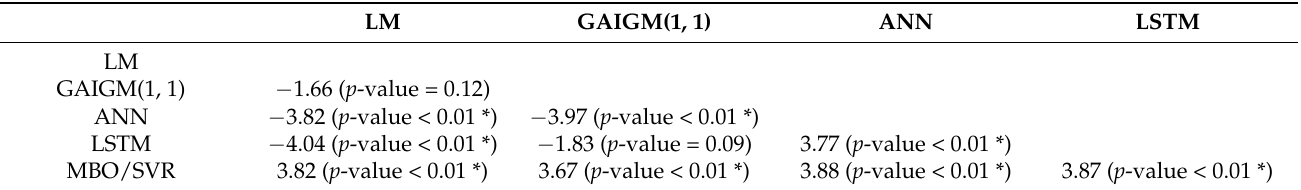
Table 7. The Diebold–Mariano test for the models. LM GAIGM(1, 1) ANN LSTM